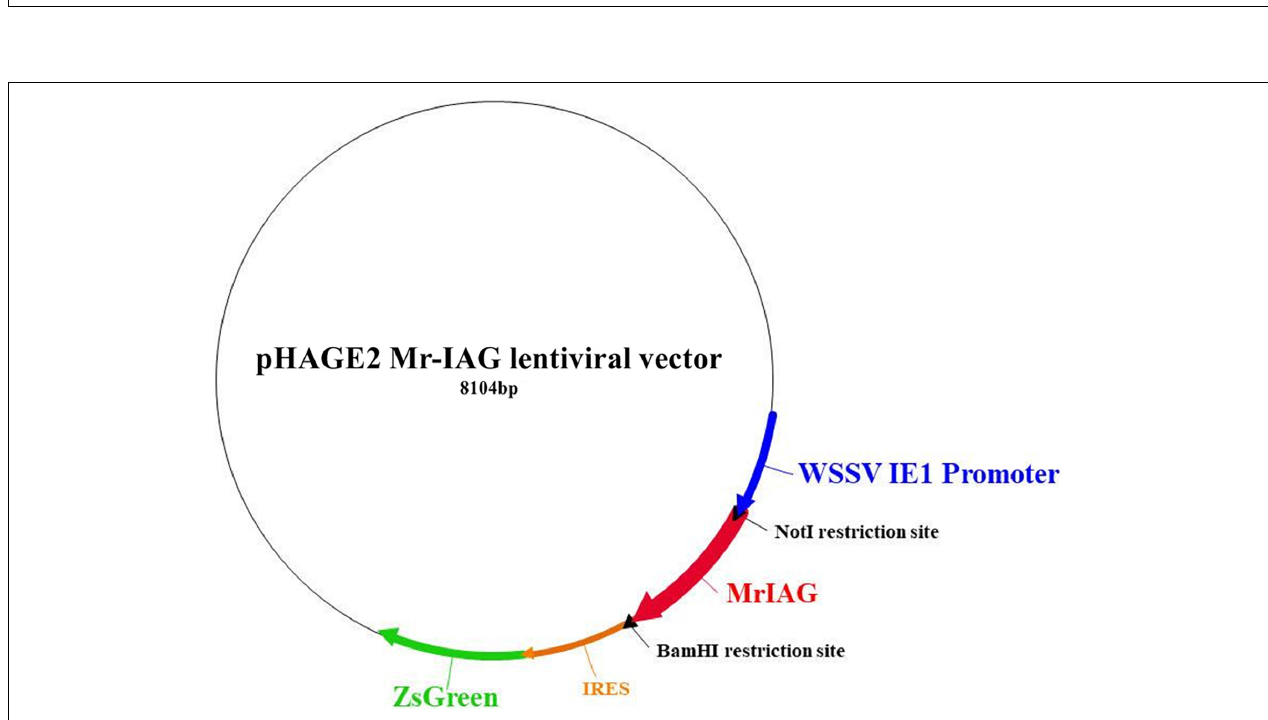
FIGURE 2 | Insertion of the Mr-IAG sequence into the WSSV IE1 pHAGE2 lentiviral plasmid. The sequence of Mr-IAG mRNA was inserted and ligated into the WSSV IE1 lentiviral plasmid (bold red arrow) instead of DsRed, which was restricted out by using Not I and Bam HI restriction enzymes. The novel Mr-IAG lentiviral plasmid was sequenced, aligned, and